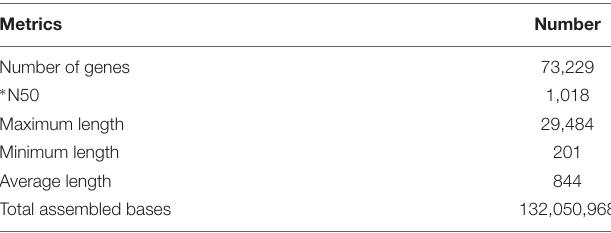
TABLE 2 | Summary of RNA-seq metrics from Ostrinia furnacalis midgut transcriptomes. Metrics